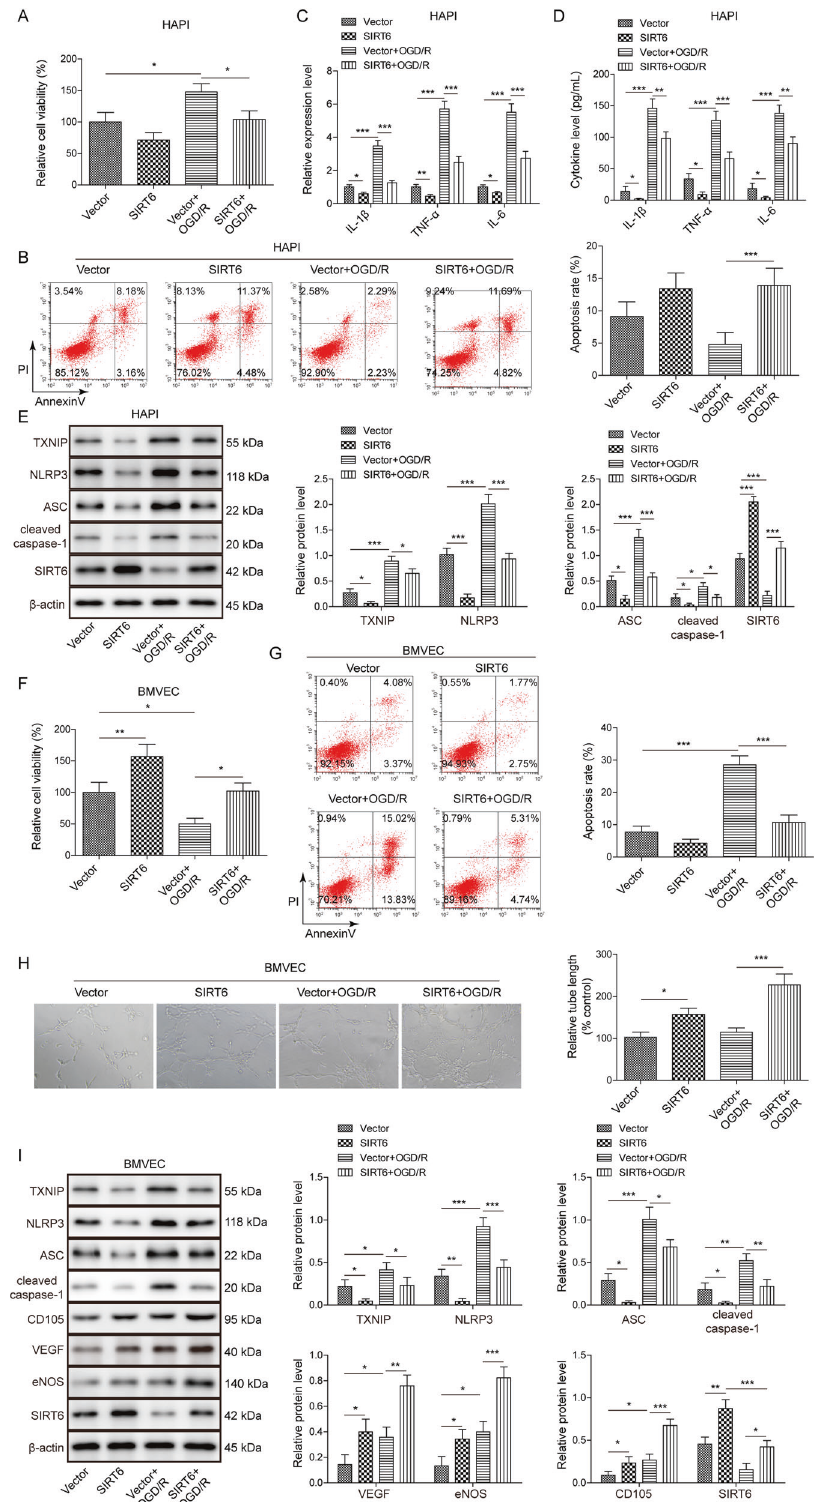
Fig. 4 Overexpression of SIRT6 alleviates OGD/R-induced microglial activation in HAPI cells, and potentiates OGD/R-induced angiogenesis in BMVECs. HAPI cells or BMVECs were infected with lentivirus for 48 h prior to OGD/R treatment. A The cell viability of HAPI cells was monitored by MTT assays. B The cell apoptosis of HAPI cells was monitored by Annexin-V/PI staining. C , D The mRNA or secretion levels of cytokines in HAPI cells were determined by qRT-PCR and ELISA assay, respectively. E The protein levels of target proteins in HAPI cells were determined by Western blotting. F The cell viability of BMVECs was monitored by MTT assays. G The cell apoptosis of BMVECs was monitored by Annexin-V/PI staining. H The angiogenesis of BMVECs was evaluated by tube formation assay. I The protein levels of target proteins in BMVECs were determined by Western blotting. β -actin acted as a loading control for Western blotting. * p < 0.05, ** p < 0.01, and *** p < 0.001.